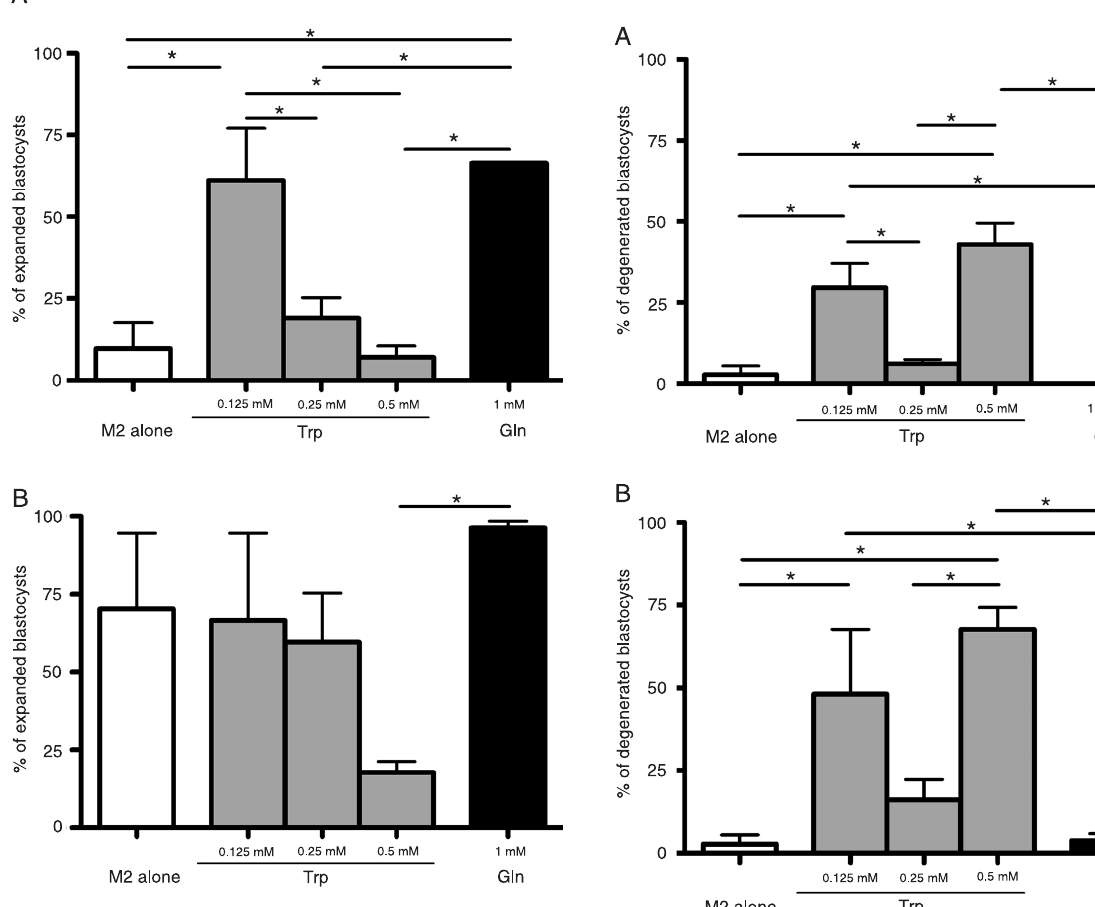
Figure 3. Effect of Trp and Gln on blastocyst expansion. The figure shows the percentage (means ± SEM) of expanded blas- tocysts at 48 and 72 h of incubation in M2 medium alone (open bar), or medium plus 0.125 mM Trp, 0.25 mM Trp, 0.5 mM Trp (gray bars), or 1 mM Gln (black bar). The expansion of the blas- tocysts cultured in the medium containing 1 mM Gln or 0.125 mM Trp was significantly higher than in the other conditions at 48 h (A); expansion of the blastocysts at 72 h was highest in the me- dium containing 1 mM Gln (B). *P < 0.05 (one-way ANOVA).